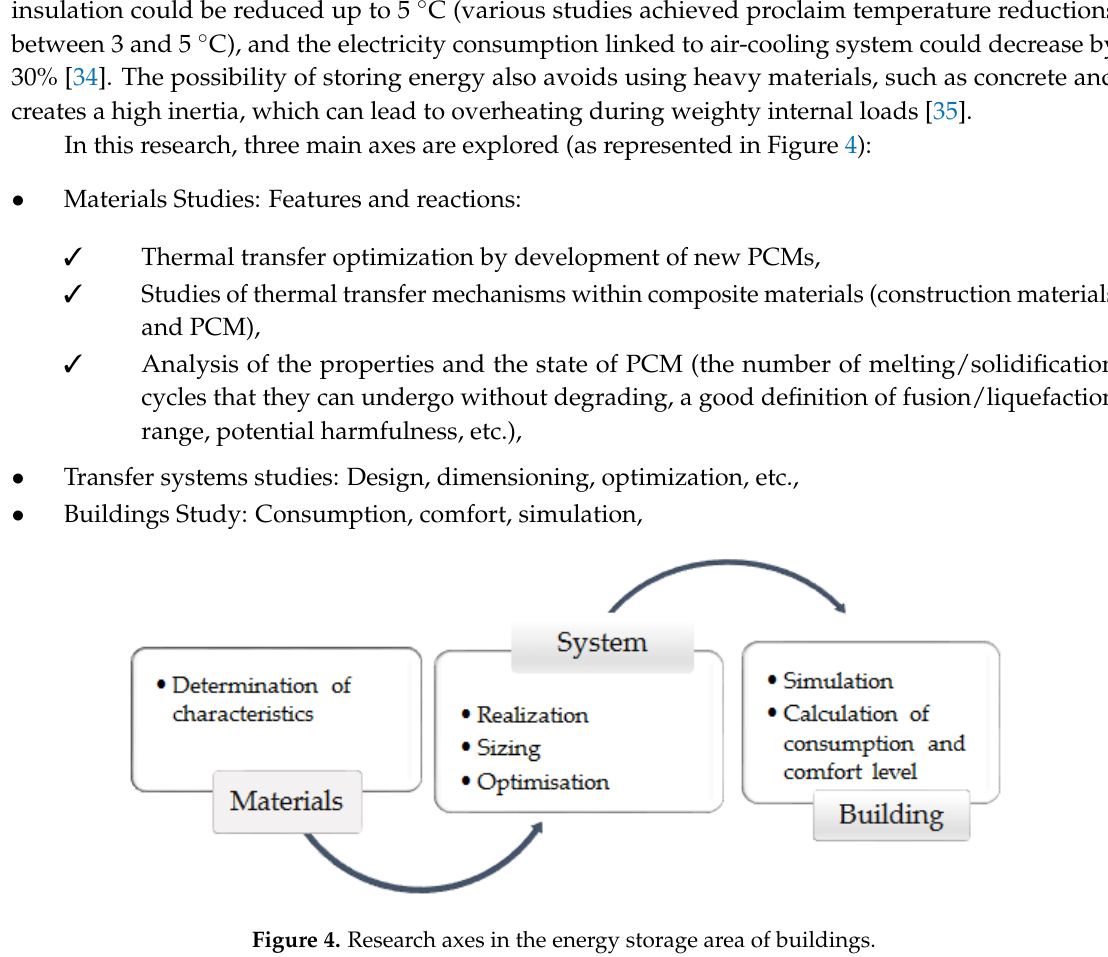
Figure 4. Research axes in the energy storage area of buildings.